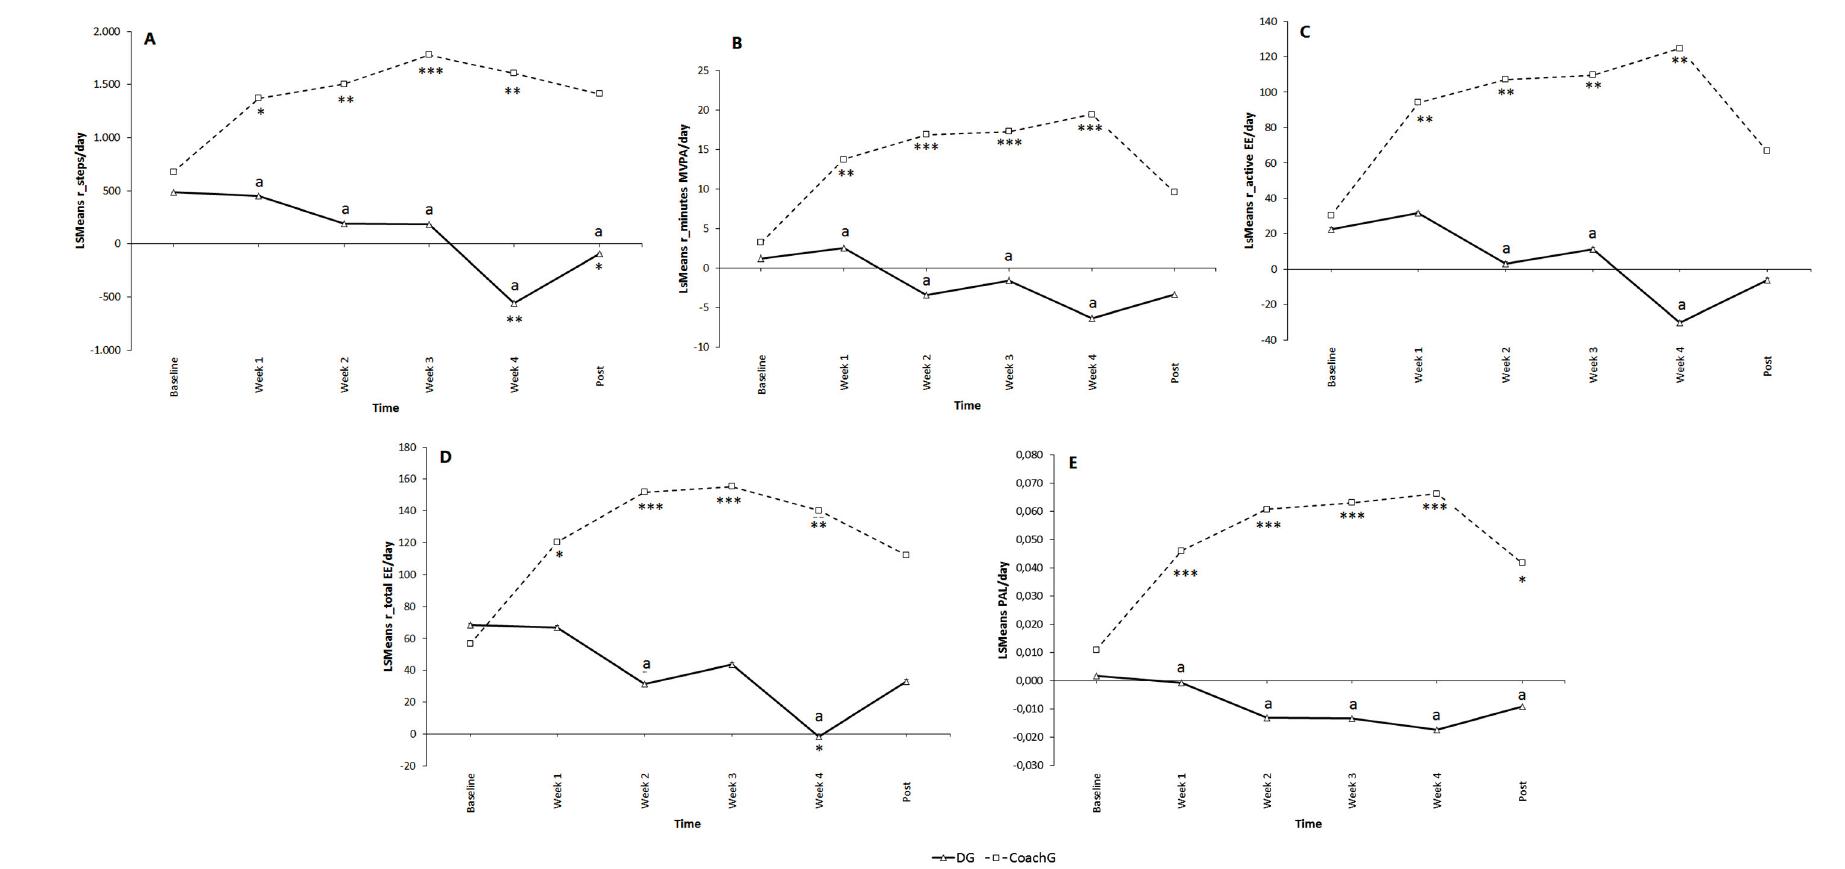
Figure 5. Residuals for steps ( A ), minutes of moderate to vigorous physical activity ( B ), total energy expenditure ( C ), active energy expenditure ( D ) and physical activity level ( E ) at baseline, week 1, week 2, week 3, week 4 and post 1 for the Display Group (DG) and the Coaching Group (CoachG). Data are expressed as least square means (LSMeans). Interaction effects between Group and Time are presented. The letter a indicates a significant difference between DG and CoachG at p < 0.05; an asterix (*) indicates a significant difference to baseline measurement within the DG and CoachG; * p < 0.05; ** p < 0.01; *** p < 0.001. Key: PA: Physical Activity; EE: Energy